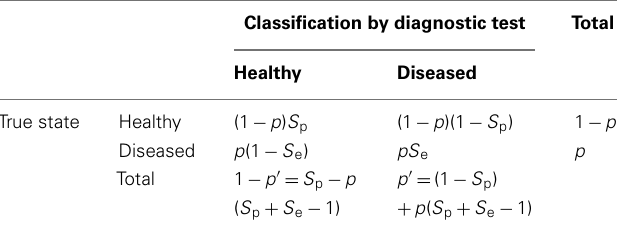
Table 1 | Proportions of individuals classified as healthy or diseased, as a function of specificity ( S p ) or sensitivity ( S e